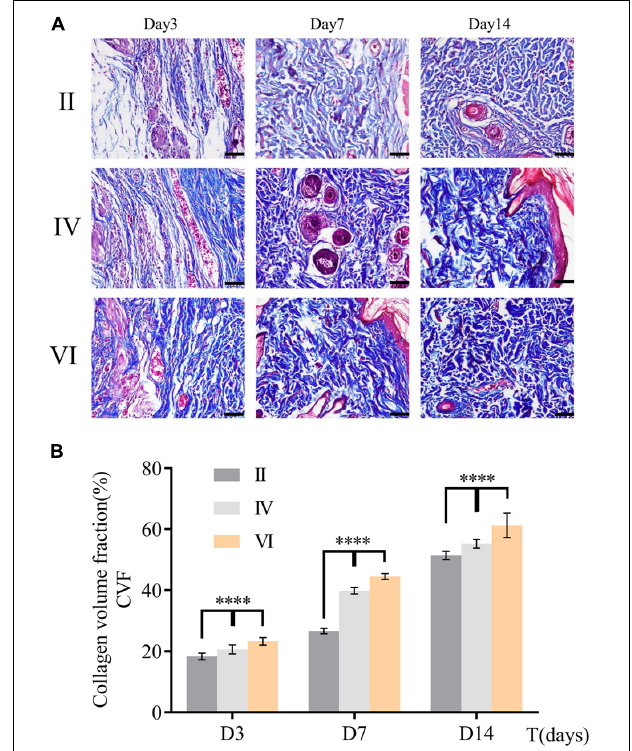
FIGURE 8 | (A) Masson’s trichrome staining of skin sample in group B, D, and F during wound healing at different days (3, 7, and 14). Scale bar = 200 µ m. (B) Collagen volume fraction was calculated by ImageJ. ( n = 3, data = mean ± SD.) (II: NIR; IV: HA hydrogel + NIR; and VI: CuS/HA hydrogel +